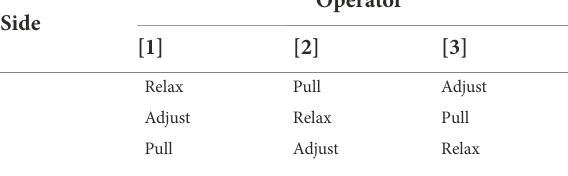
dotted magenta arrow in Figure 1A. The adjusting role needed to change the tension flexibly and maintain overall balance to the extent that the pen did not greatly deviate from the inside, shown by the dotted black arrow in Figure 1A. This study focused on the third role because such a role is required regardless of group activity type. In learning and debate studies, a facilitator who promotes smooth and active interaction is important (e.g., Berta et al., 2015; Lessard et al., 2015). Therefore, we hypothesized that the adjusting role as a facilitator was crucial for high task performance in the coordinated drawing task. In the experiment, the pen positions and tensions were measured, and statistical models were established to fit the analyzed data. To investigate which roles were related to improved performance, we estimated the relationships between (1) performance and trial, and (2) improved performance through trials and three-role actions.